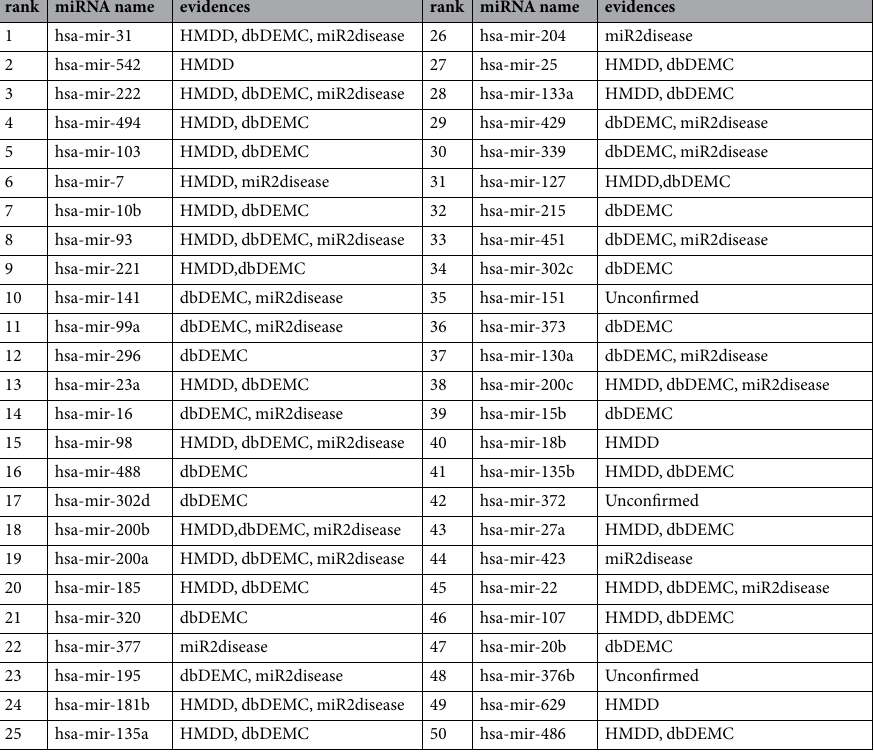
cancer. Underlying lung cancer-related miRNA candidates were predicted by ILRMR based on 72 known asso- ciations. Table 2 provides the top 50 lung cancer-related miRNAs predicted by ILRMR. One typical example is hsa-miR-31, which ranked first in predictive results. Recent studies 39 demonstrated close connection of miR- NAs to clinicopathological parameters in clinical stages of lung cancer. Hsa-mir-31 expression significantly increases in lung cancer patients with poor survival 40 . Among the top 50 prediction list, 47 miRNAs were ver- ified by HMDD, dbDEMC, and miR2Disease; and only hsa-mir-151, hsa-mir-372, and hsa-mir-376b were not confirmed. However, Leidinger P. et al . 41 demonstrated that hsa-mir-151 is upregulated in non-small cell lung carcinoma compared with non-tumorous tissues. As described in literature 42 , T. Nijjar et al . identified that low expression level of hsa-mir-372 can be associated with recurrence case groups of stage I of non-small cell lung cancer. Evidence supported by literature further confirms reliability of ILRMR in predicting new underlying disease-related miRNA candidates. Breast cancer is a malignant tumor that occurs in glandular epithelium of breasts and is regarded as the first major harm to women’s health 43 . In the predictive dataset, 78 miRNAs are related to breast cancer. As shown in Supplementary Table 1, 48 of the top 50 breast cancer-related miRNA candidates predicted by ILRMR were con- firmed by the three databases mentioned above. For example, hsa-mir-340 44 , which ranked first in the predictive list, inhibits migration and development of breast cancer cell by targeting oncoprotein c-Met. hsa-mir-301a and hsa-mir-301b 45 ranked third and ninth, respectively; they are pivotal oncogenes in human breast cancer and pro- mote nodal or distant relapses through multiple pathways. hsa-mir-7 46, 47 family is regarded as tumor suppressor to migration of breast cancer. In our experiment, hsa-mir-7i, hsa-mir-7b, and hsa-mir-7g are ranked first in the top 10 list. Applicability of ILRMR to predict diseases without any known associated miRNAs. To further verify the ability of ILRMR to predict diseases without any known associated miRNAs, we removed known verified miRNAs-disease associations on predictive diseases mentioned in the predictive dataset. This procedure ensured that prediction only considered similar information and known miRNA-disease association of other diseases. We deployed case studies for lung cancer and breast cancer, and predictive results are listed in Supplementary Table 2 and Table 3, respectively. For lung cancer, we removed 72 known miRNA-lung-cancer-related associations to predict underlying associations by ILRMR. Among the top 50 potential lung cancer miRNA candidates, 48 were based on recently updated HMDD, dbDEMC, and miR2Disease. For breast cancer, 78 known associations related to breast cancer were removed, and 47 of the top 50 predicted miRNAs were verified. The top 30 predictions for lung cancer and breast cancer were all confirmed. Therefore, ILRMR exhibits excellent performance in predicting diseases without known associated miRNAs. Topical subheadings are allowed.